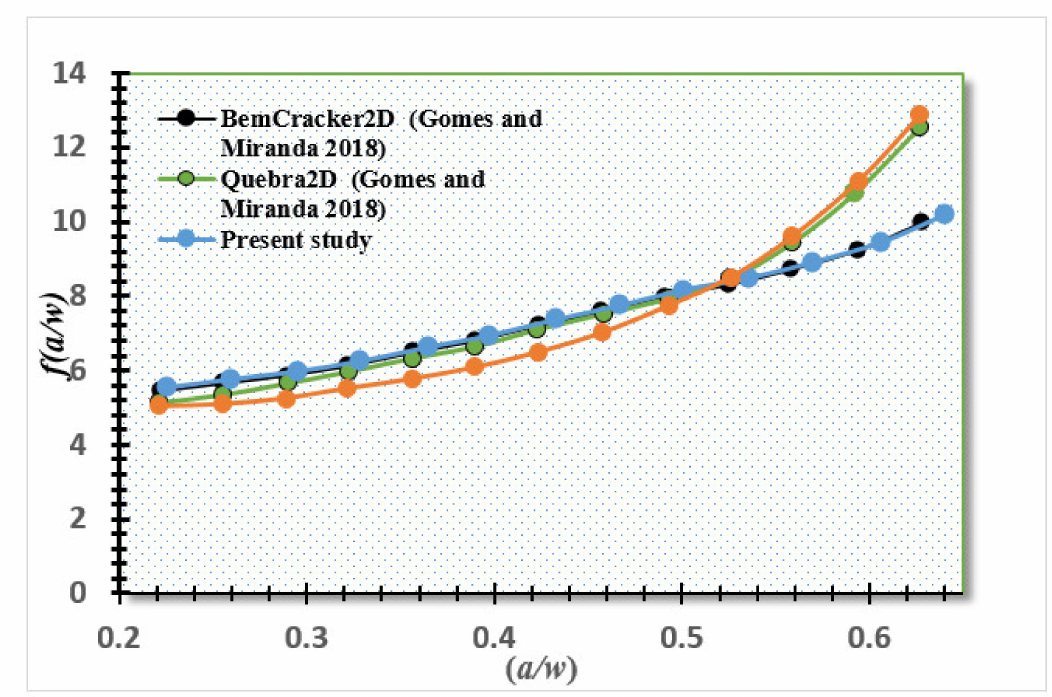
Figure 13. Dimensionless SIFs of CTS03 compared to the analytical solution and the work of